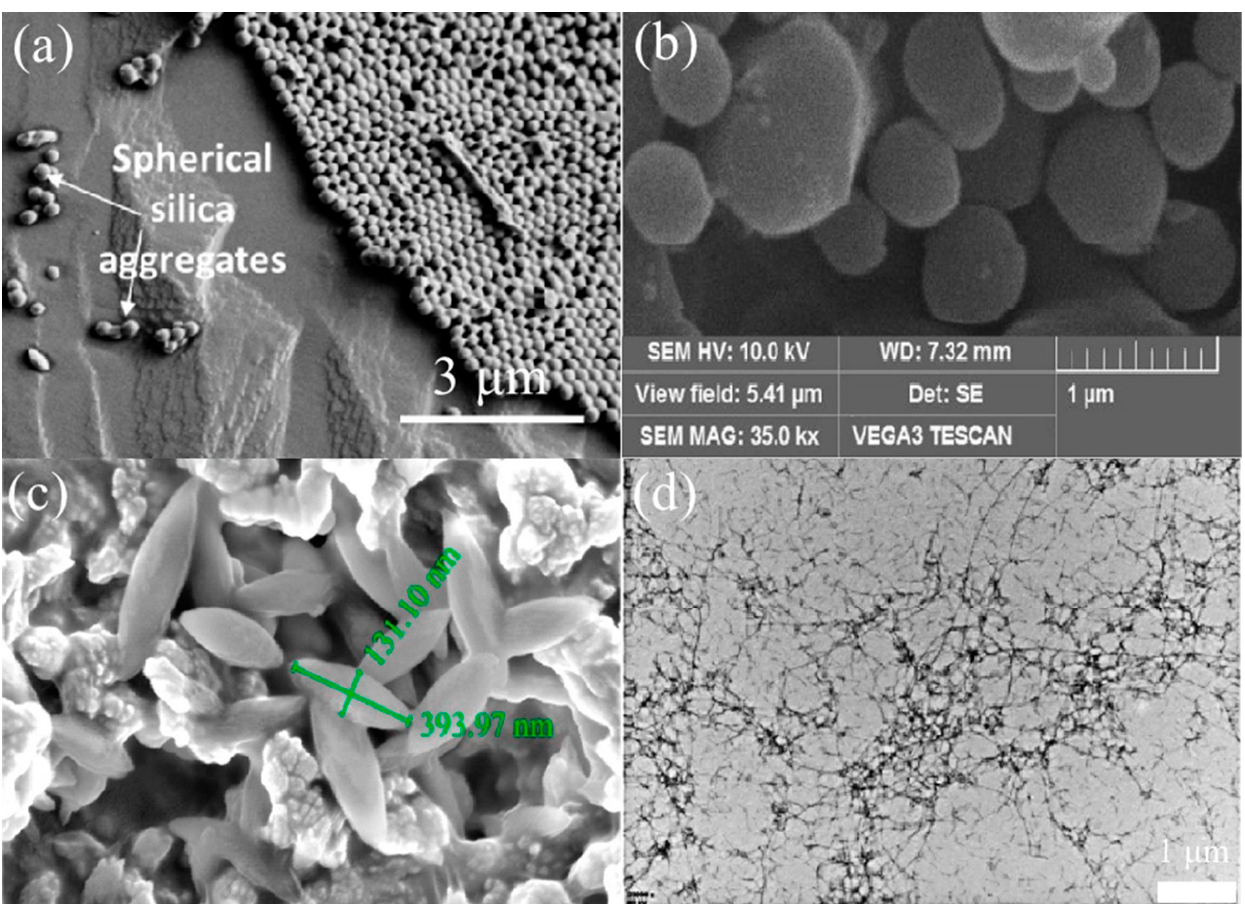
Figure 7. ( a ) Arrangement of spherical particles. ( b ) Microstructure of spherical particles. ( c ) Microstructure of spindle-shaped particles. ( d ) Microstructure of flocculent particles. Adapted from [42, 85, 98, 103] with permission from Elsevier Ltd, 2023.